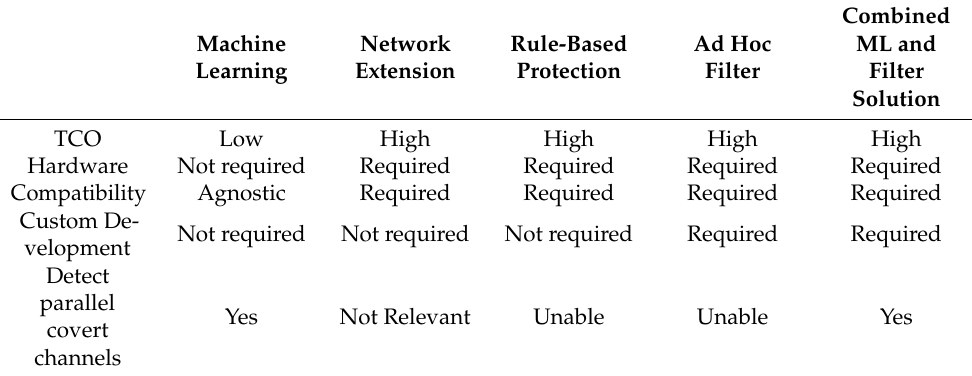
Table 1. Secure communication methods